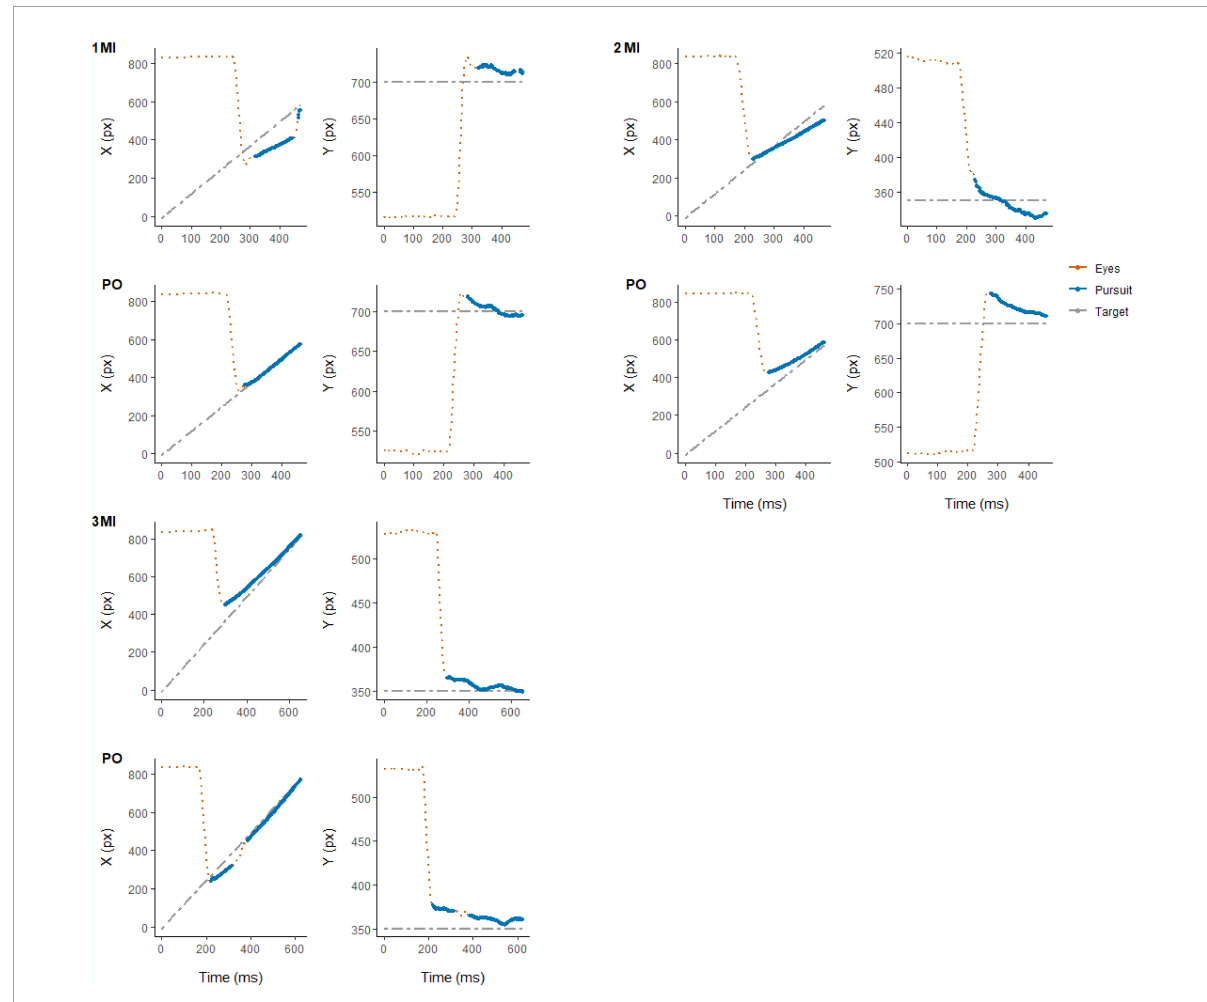
FIGURE3 Representative example of eye (in red) and target (in gray) position for individual trials in each experimental condition (MI and PO) from randomly selected participants: 3 (top-left), 7 (top-right), and 23 (bottom-left). Eye movement signals classified as smooth pursuit are highlighted (in